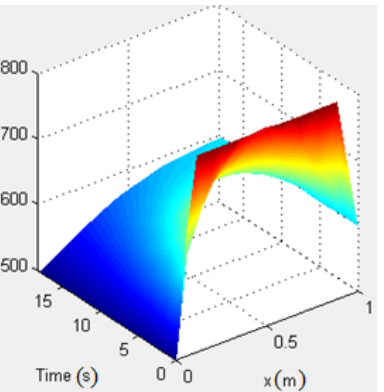
Figure 3. Appearance of the temperature profile at the ignition